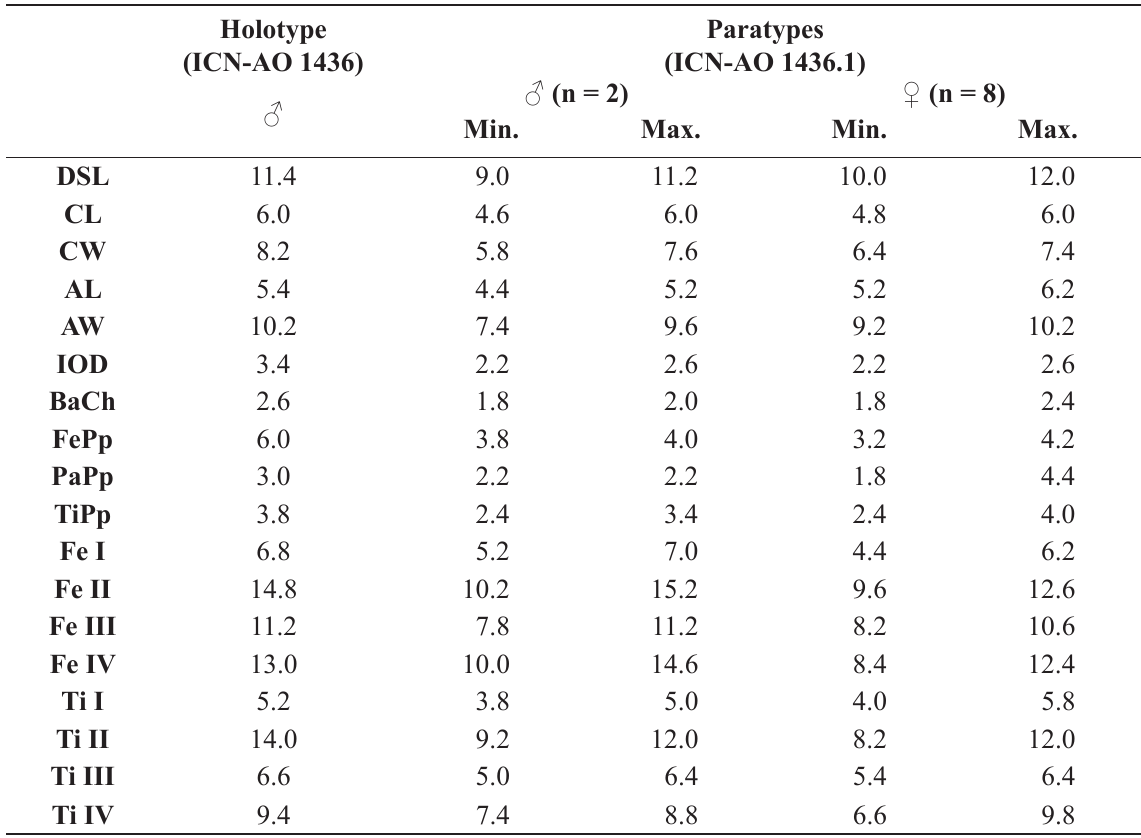
Table 7. Phalangodus kuryi sp. nov. measurements of body and appendage, in